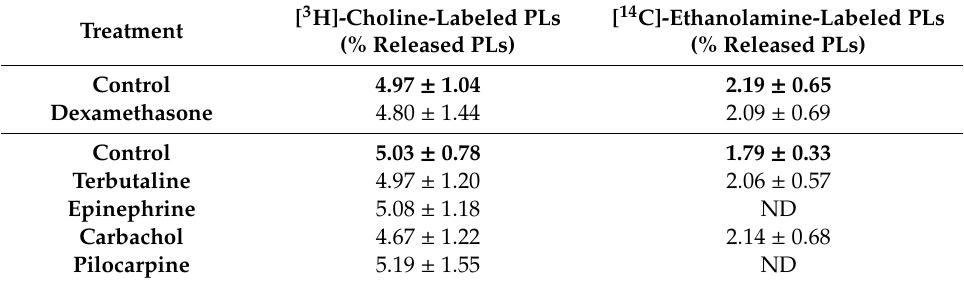
Table 2. The e ff ects of dexamethasone as well as adrenergic and muscarinic receptors agonists on the release of